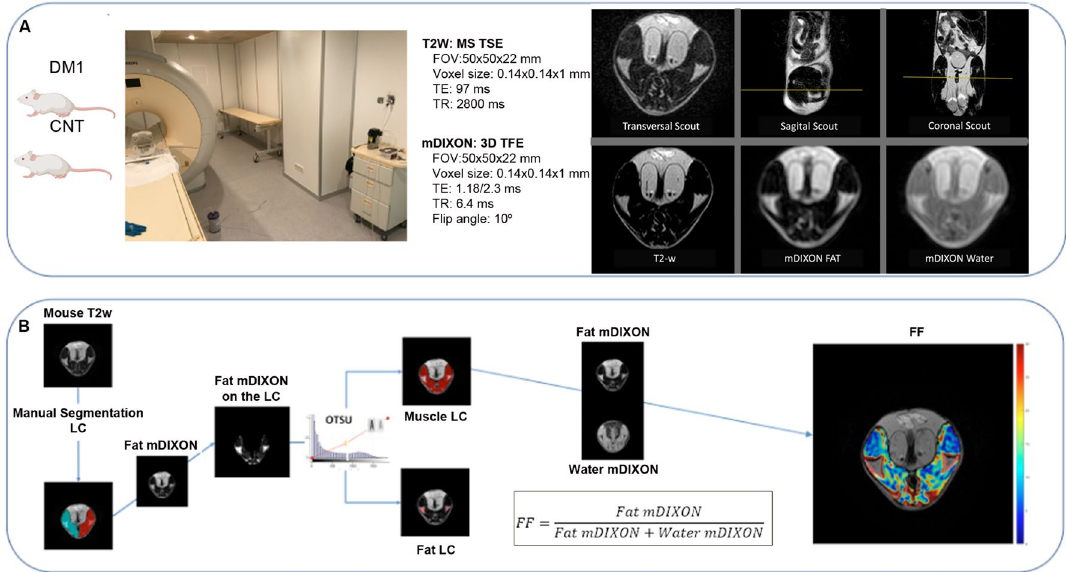
Figure 2. Summary of image acquisition and analysis workflow. The image depicts the infrastructure used for mouse sedation and MRI acquisition, showing both the angulation and the main parameters of the sequences used to obtain the cross-sectional images of a DM1 model mouse thigh ( A ), along with the workflow of muscle compartment segmentation, the automatic segmentation of fat and muscle, and the postprocessing used to obtain the muscle/fat fraction mapping ( B ). LC leg compartment, FF fat fraction. Figure partially created with BioRender.com.